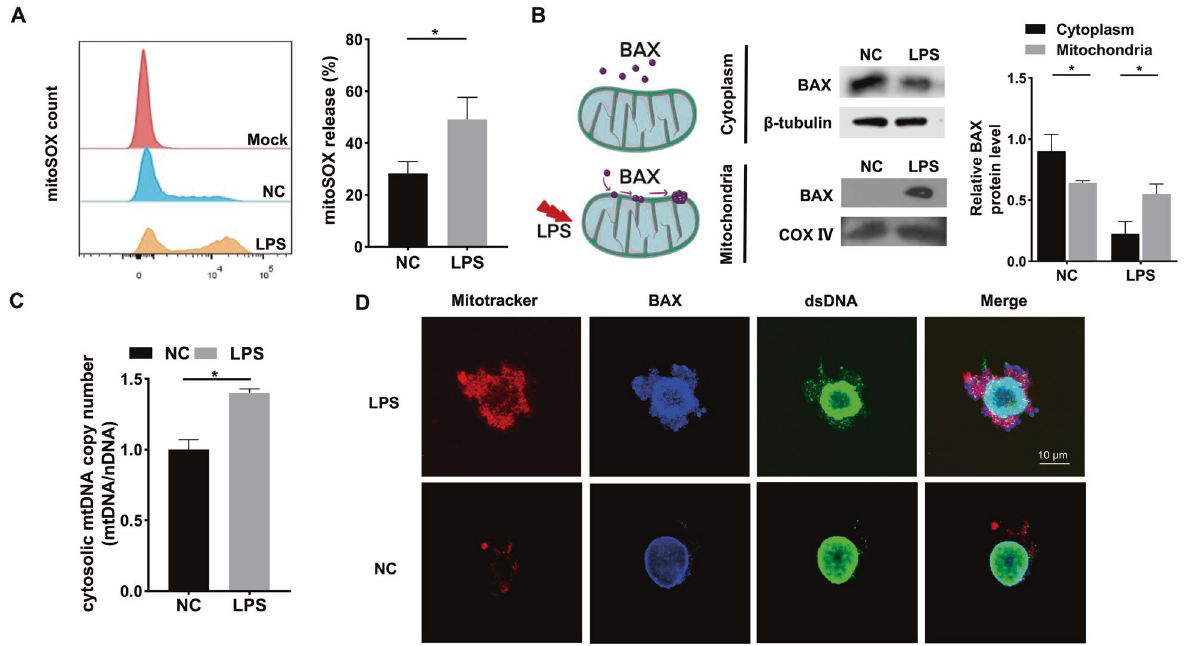
Fig. 1 LPS-induced mitochondrial damage and mtDNA leakage into cytosol via BAX. A The release rate of mitoSOX in NC and LPS groups was measured by fl ow cytometry ( n = 3). B The cytoplasmic and mitochondrial protein level of BAX was analyzed by Western blotting after LPS stimulation (20 μ g/ml, 24 h). β -tubulin served as the loading control for cytoplasm. COX IV served as the loading control for mitochondria. C qPCR was performed to assess the cytosolic mtDNA copy number in mDPC6T cells after LPS treatment. D Confocal microscopy to detect the co-location of immuno fl uorescence labeled mitochondria, BAX and dsDNA after 24 h of LPS treatment. MitoTracker stained mitochondria (red). Anti-BAX antibodies stained BAX (blue). Anti-dsDNA antibodies stained double-stranded DNA (green). Scale bar: 10 μ m. The data are the means ± standard deviations of 3 independent experiments ( p < 0.05 * , p < 0.01 ** , p < 0.001 ***